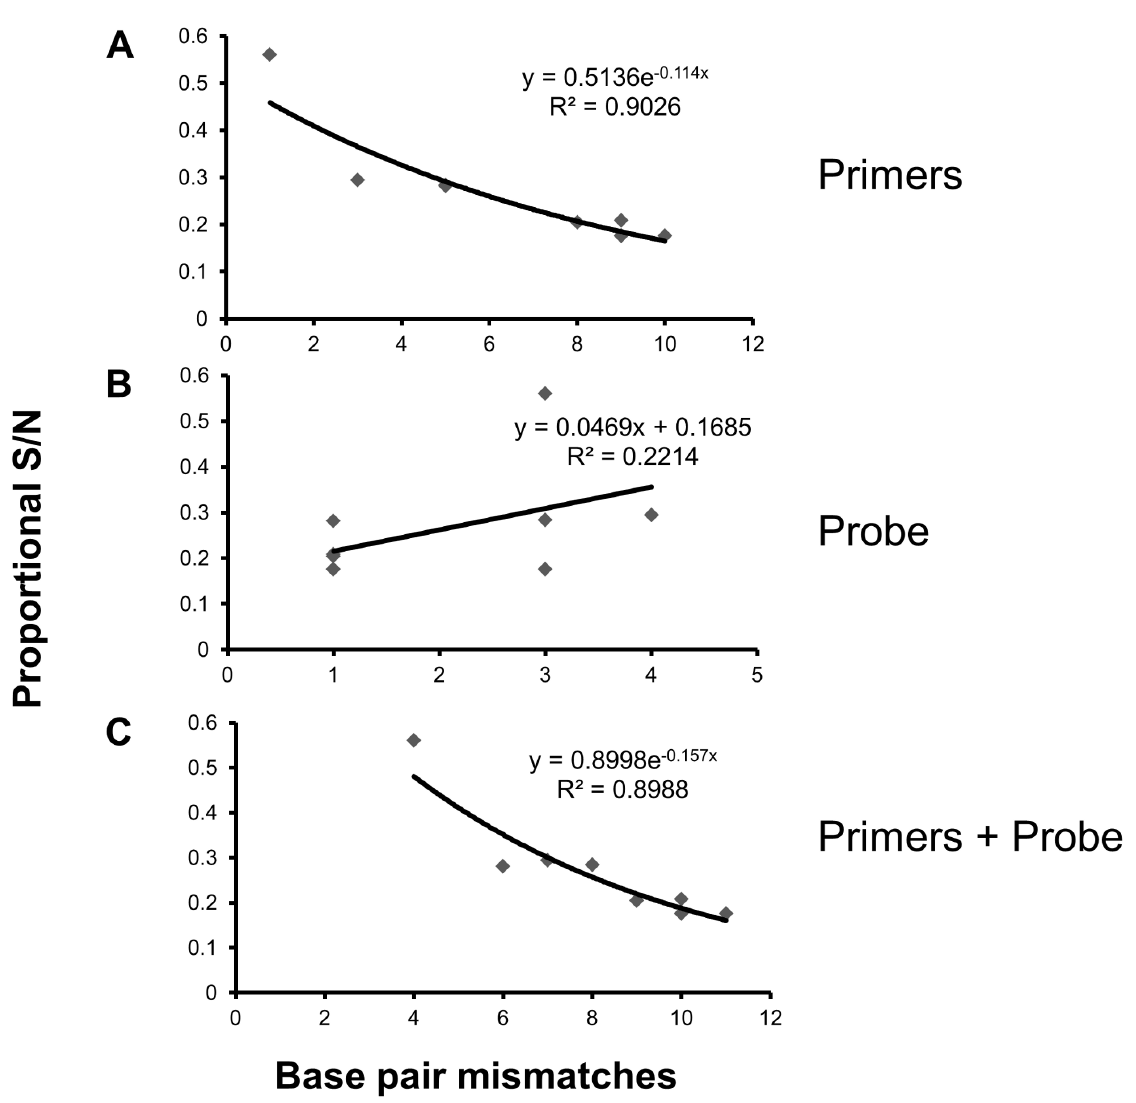
Figure 1. Impact of base pair mismatches on fluorescence. The relationship between end-point fluorescence (measured as proportional S/N; the fluorescence at cycle 40 divided by the fluorescence at cycle 1 as a proportion of a positive control) and base pair mismatches in the primer regions (A), probe region (B), and primers and probe regions combined (C). End-point fluorescence decreases as the number of primer base pair mismatches